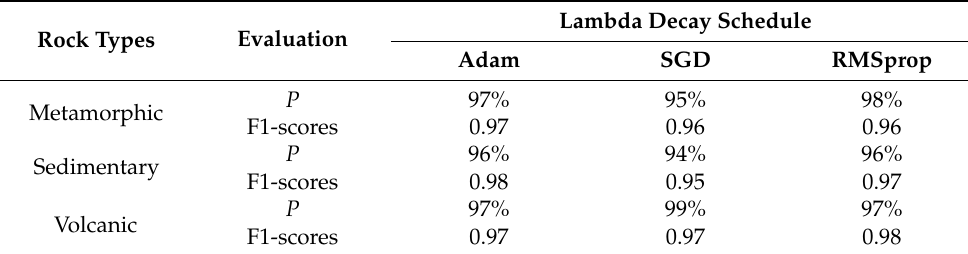
Figure 16. Confusion matrixes: ( a ) RMSprop optimizer; ( b ) SGD optimizer; ( c ) Adam optimizer. Additionally, the average classification accuracy of the VGG16 model under the two learning-rate decay modes for the three types of rock was 96.6%, 95.8%, and 98.3% and 96.7%, 95.3%, and 97.6%, respectively, and the difference is small, as shown in Table 5. Table 5. Detailed classification results for all rock types.